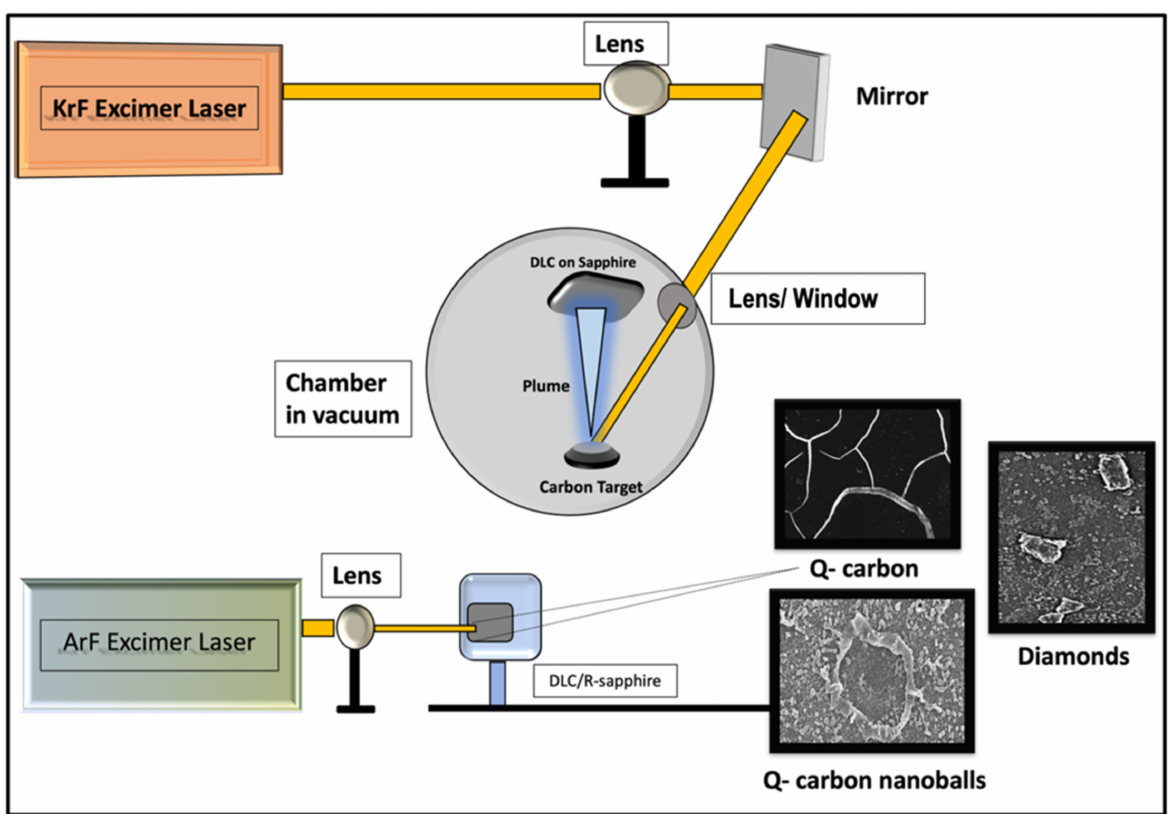
Figure 1. Schematic of pulsed laser deposition of DLC film on r-sapphire and subsequent pulsed laser annealing (PLA) of the film to form Q-carbon, Q-carbon nanoballs and diamond film based on selective quenching and undercooling by different energy